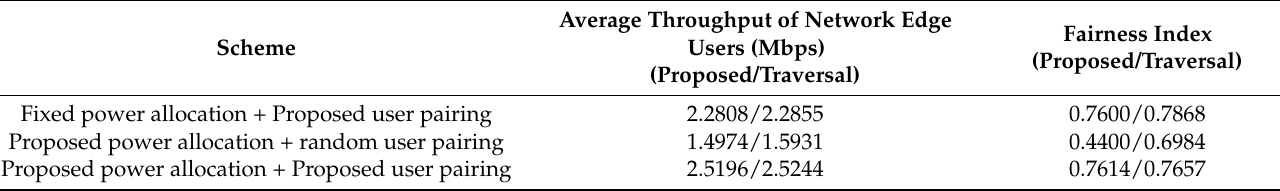
Table 2. Simulation results under different schemes.